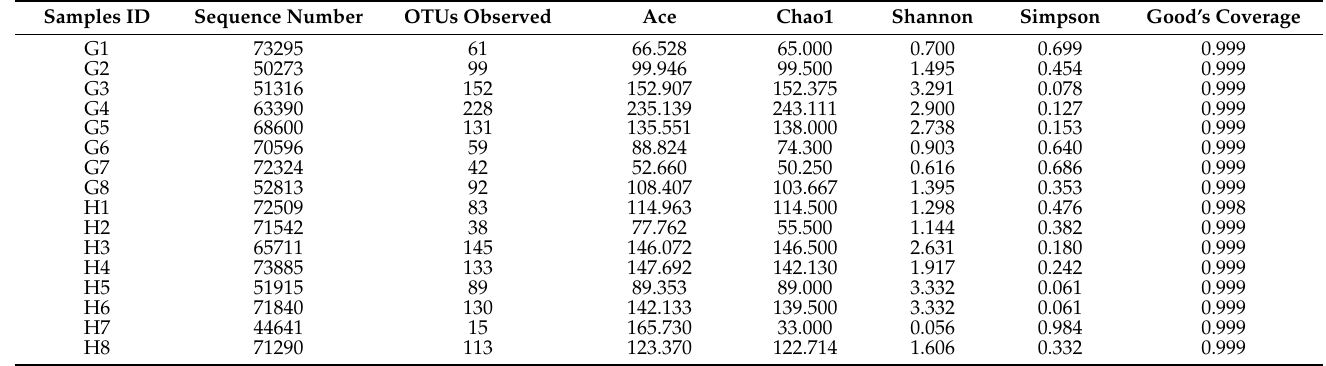
Table 4. Fungal alpha diversity levels in Suanyu samples from different